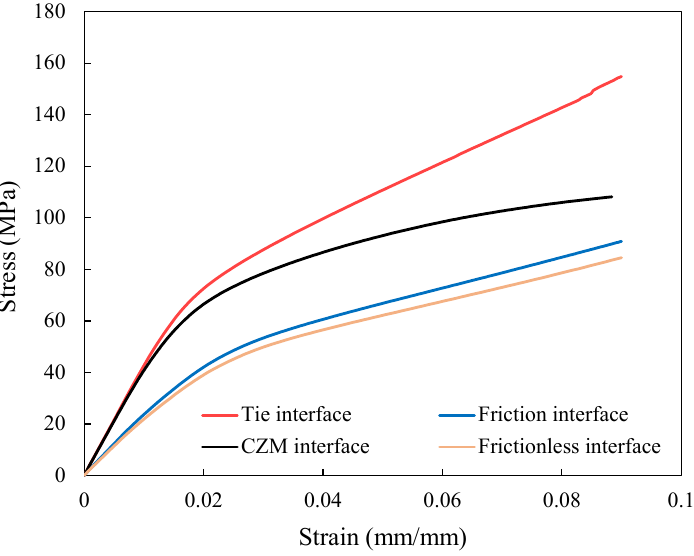
Figure 8. Prediction of stress-strain response of the knitted composite in the wale direction using different methods to model the fiber tow/matrix interfaces.